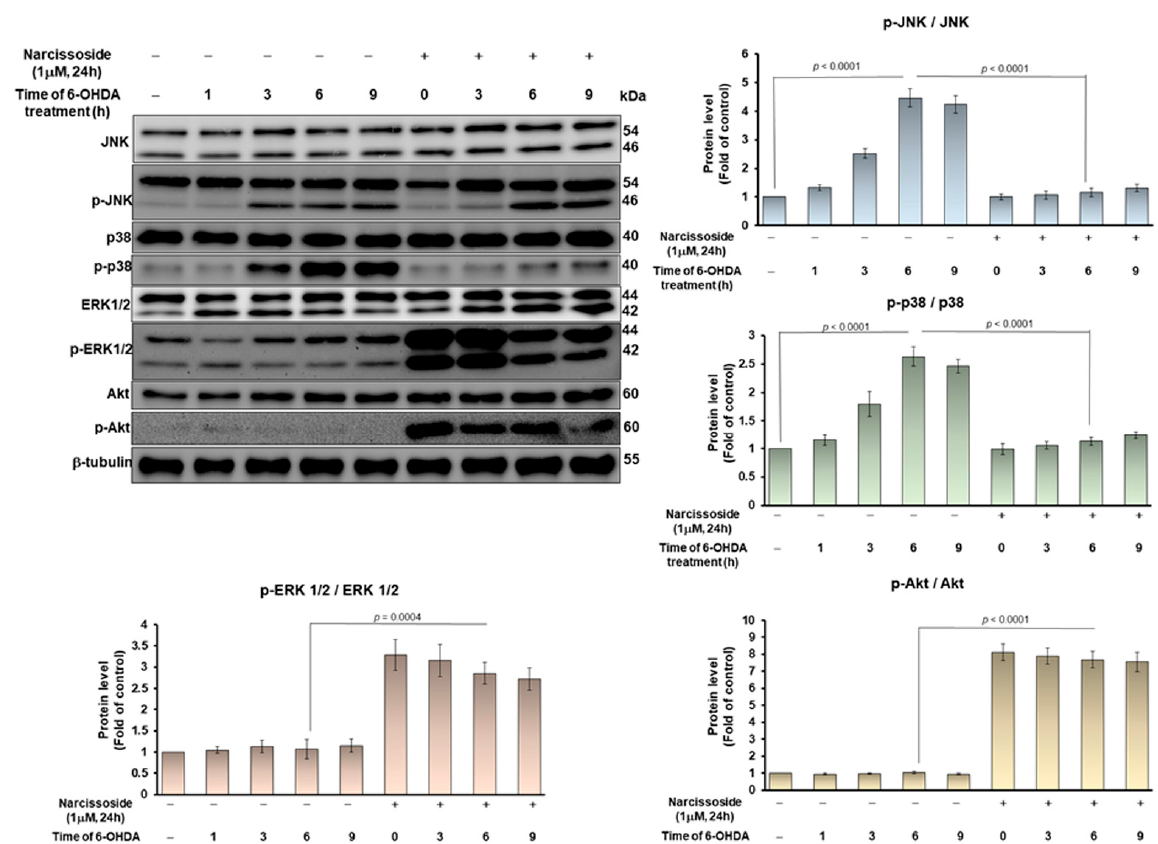
Figure 5. Narcissoside (NCS) attenuated 6-hydroxydopamine (6-OHDA)-induced phosphorylation of JNK and p38, but enhanced ERK1/2 and Akt activity in SH-SY5Y cells. Cells were pretreated with or without 1 μ M NCS for 24 h and then treated with 100- μ M 6-OHDA for 3, 6, and 9 h. Protein levels of JNK, p-JNK, p38, p-p38, ERK1/2, p-ERK1/2, Akt and p-Akt were determined by western blotting. The expression of β -tubulin is as internal loading control. (top left). The intensity of the signal was quantified by the ImageJ software. (right and bottom).